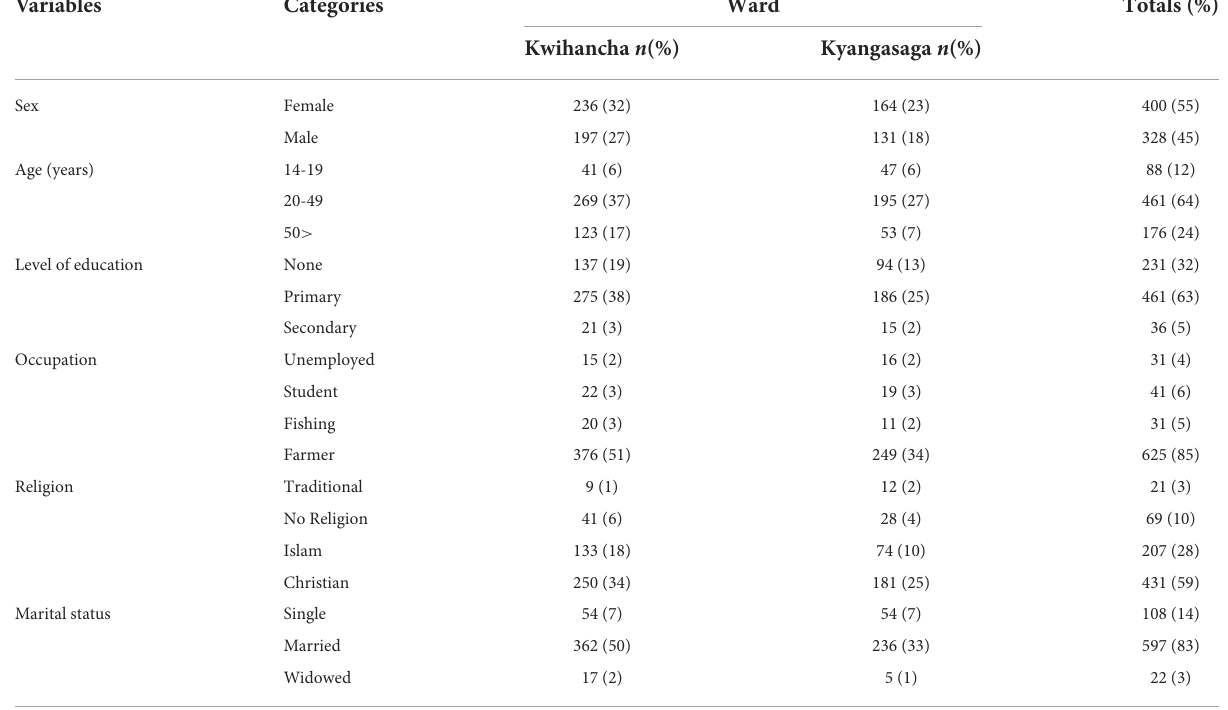
TABLE 1 Socio-demographic characteristics of household respondents.